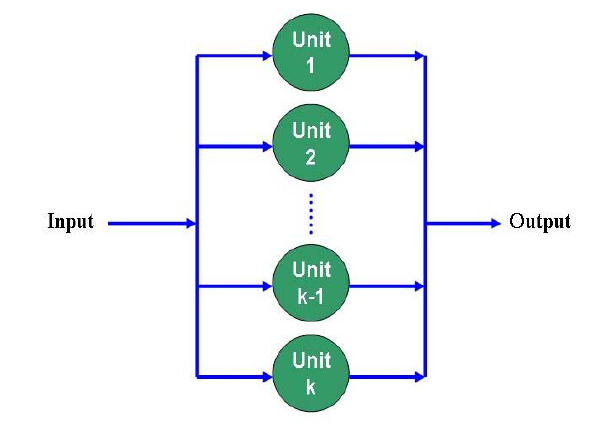
Figure 6. Network elements connected with parallel